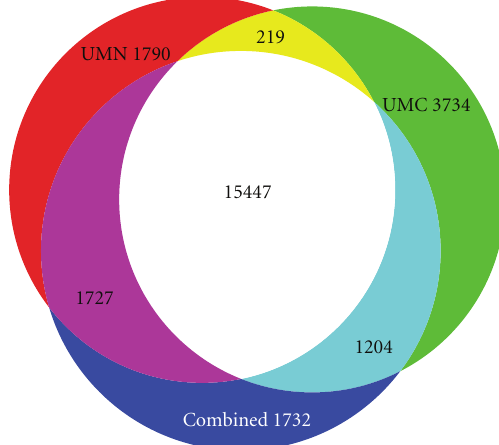
Figure 8: Venn diagram showing the overlap between probes detecting gene expression from the analysis of the University of Minnesota (UMN), University of Missouri (UMC), and combined UMN-UMC data. When the UMN and UMC data were separately analyzed 77% of the probes identified as detecting gene expression were common between both data sets. When the data sets were combined an additional 1,732 probes (7%) were identified as detecting gene